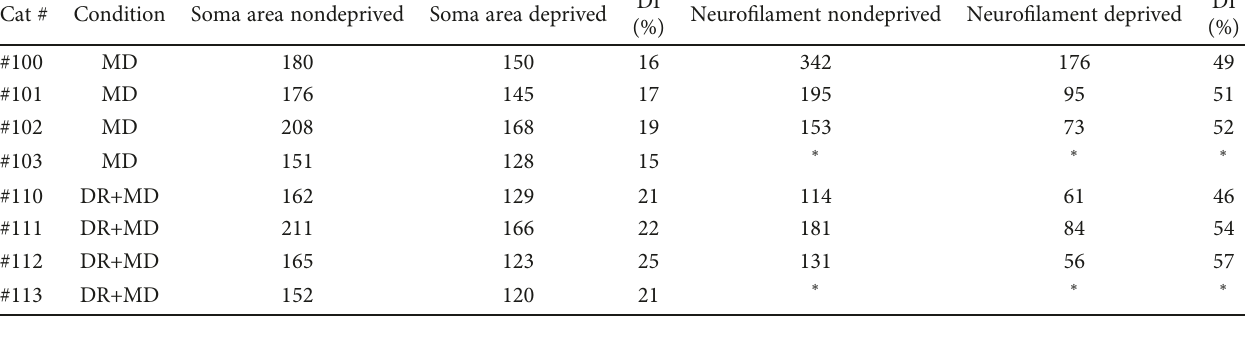
Table 2: Measurements of the average soma area ( μ m 2 ) and neuro fi lament-positive cell density (cells/mm 2 ) presented for animals across both rearing conditions in this study. Deprivation index (DI) represents the percentage di ff erence between deprived and nondeprived layers for each animal studied. Asterisks indicate measurements that were not collected because immunolabelling was insu ffi cient for quanti fi cation. Cat #